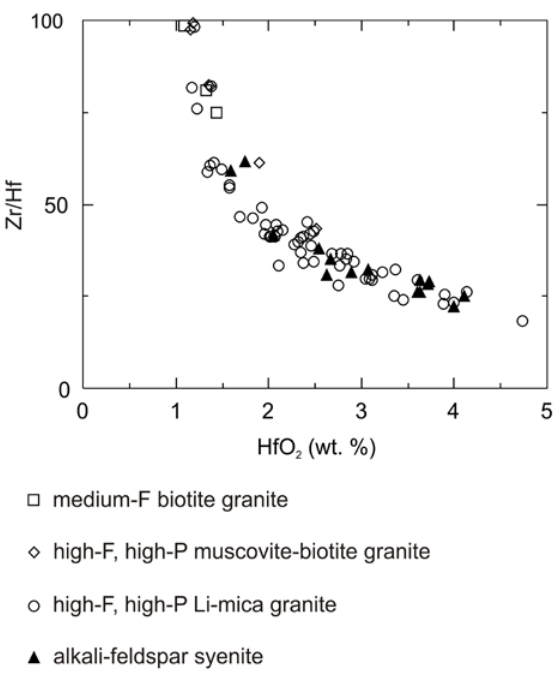
Figure 10. Chemical composition of zircon from granites of the Krudum granite body.